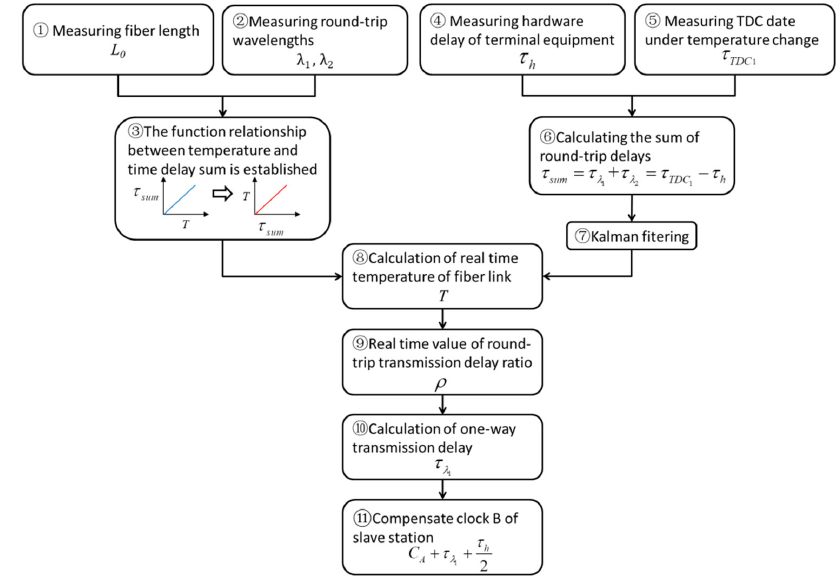
Figure 2. Flow chart of the time transfer system based on temperature tracking.